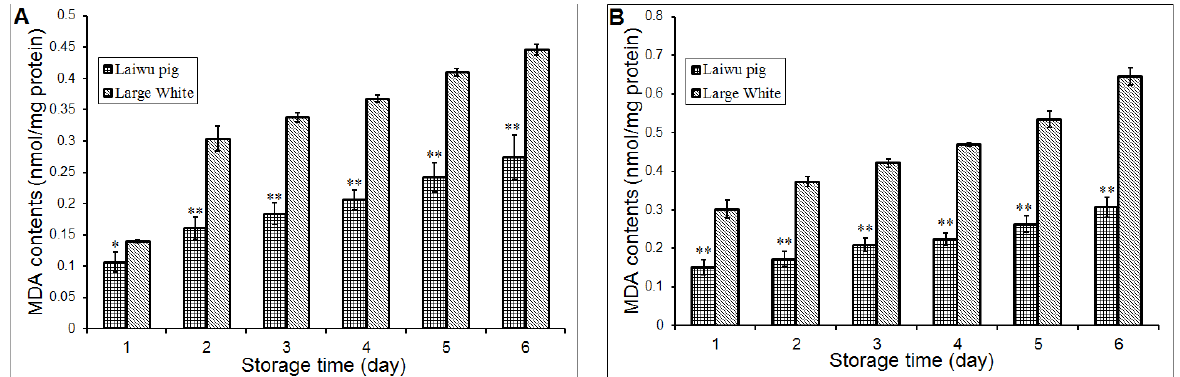
Figure 4. Comparison of muscle MDA content. The muscle samples of Laiwu pig and Large White pig stored at 4  C (A) and 20  C (B) for 1-6 days. Each value is represented as the means  SEM ( n = 6). Asterisks indicate differences that are statistically significant (* p<0.05, **